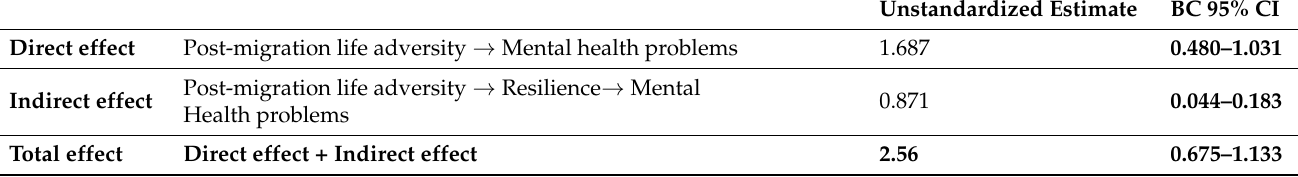
Table 6. Direct, indirect, and total effect